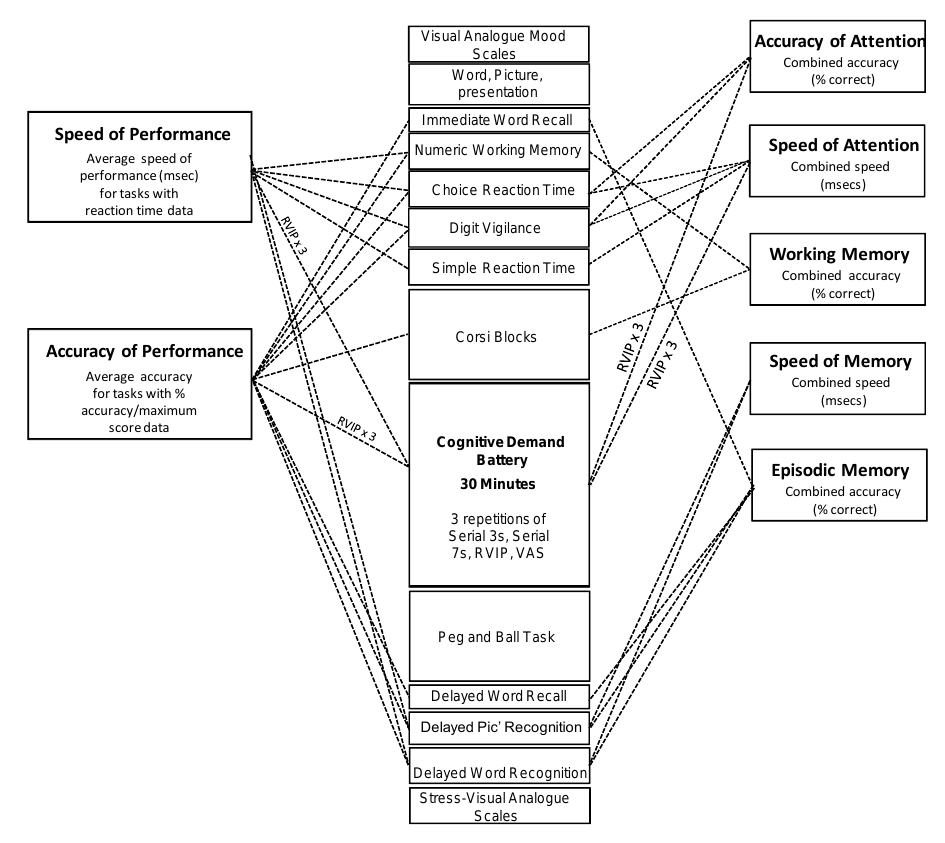
in the supplementary online materials (Section I). Rapid Visual Information Processing task